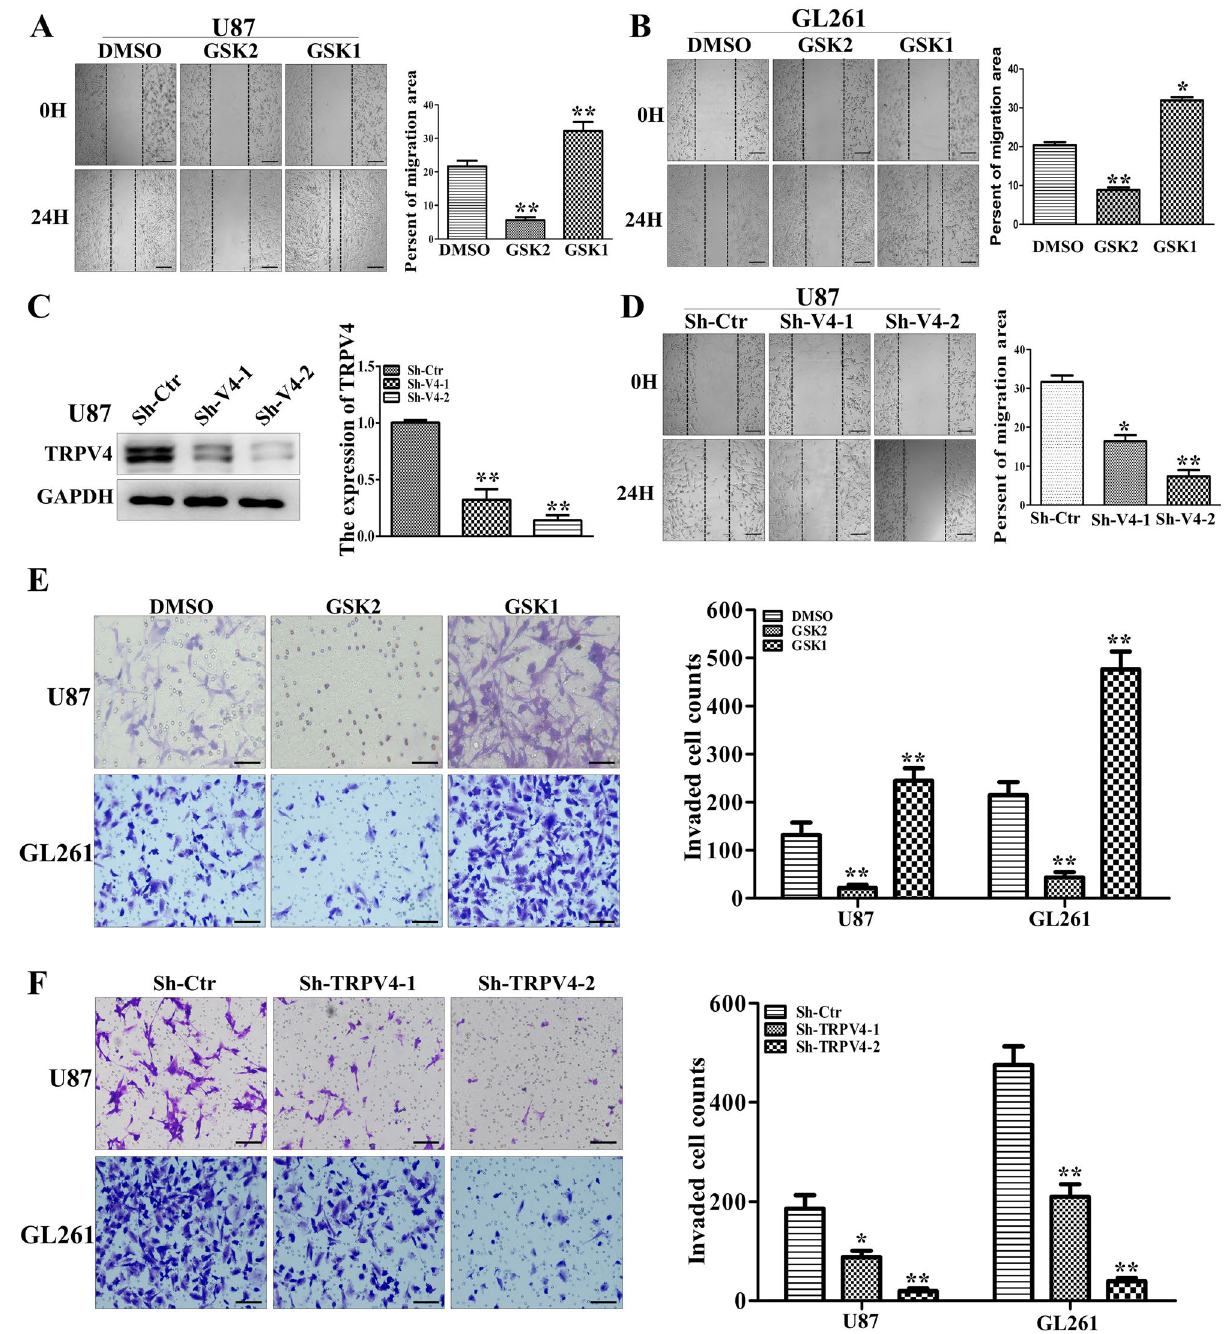
Figure 2. TRPV4 promotes the migration and invasion ability of glioblastoma cells in vitro. ( A–B ) U87 and GL261 cells were treated with the TRPV4 antagonist GSK2 (50 nM) or the agonist GSK1 (10 nM). Cells were scratched and imaged immediately (0 h) and after 24 h (left). Relative motility was quantified by measuring the cell surface area using ImageJ, scale bar = 100 µm. ( C ) The downregulation effect of two shRNAs targeting TRPV4 (sh-TRPV4-1 and sh-TRPV4-2) was detected by western blot assays. ( D ) The migration ability of U87 cells after TRPV4 downregulation was detected by wound-healing assay, scale bar = 100 µm. ( E ) Representative result (left) and histogram (right) of Transwell assays when cells were treated with DMSO, GSK2 (50 nM) or GSK1 (10 nM) in U87 and GL261 cells, scale bar = 50 µm. ( F ) Representative results (left) and histogram (right) of Transwell assays when TRPV4 was silenced by shRNA in U87 and GL261 cells, scale bar = 50 µm. Student’s t test was used for statistical analysis. * p < 0.05, ** p <